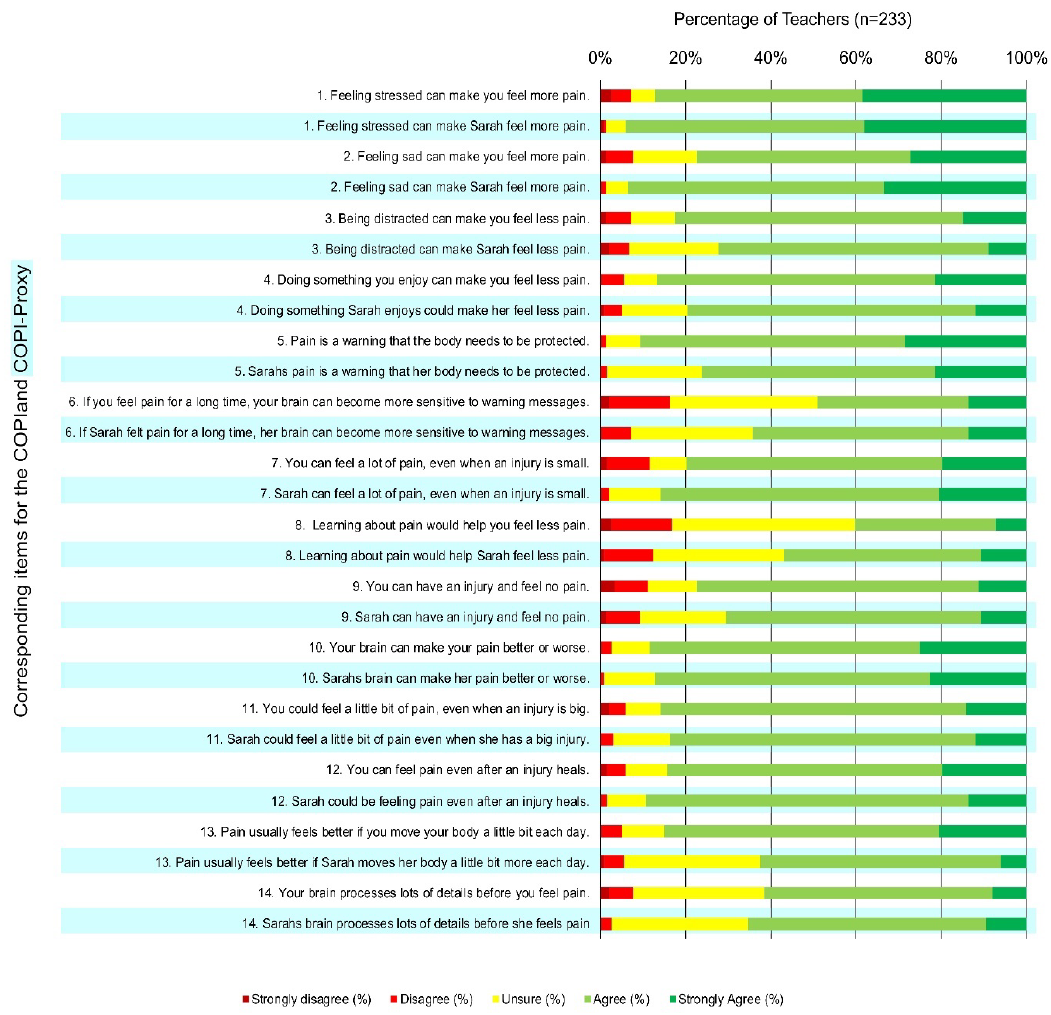
Figure 1. Distribution of scores for COPI and COPI-Proxy items.